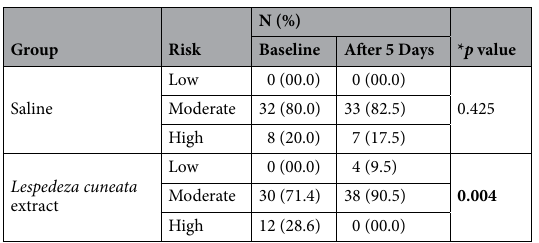
Table 4. Distribution of the subjects according to their risk differences (n = 82). * p values are determined by Fisher’s exact test ( p < 0.05); significant (bold).